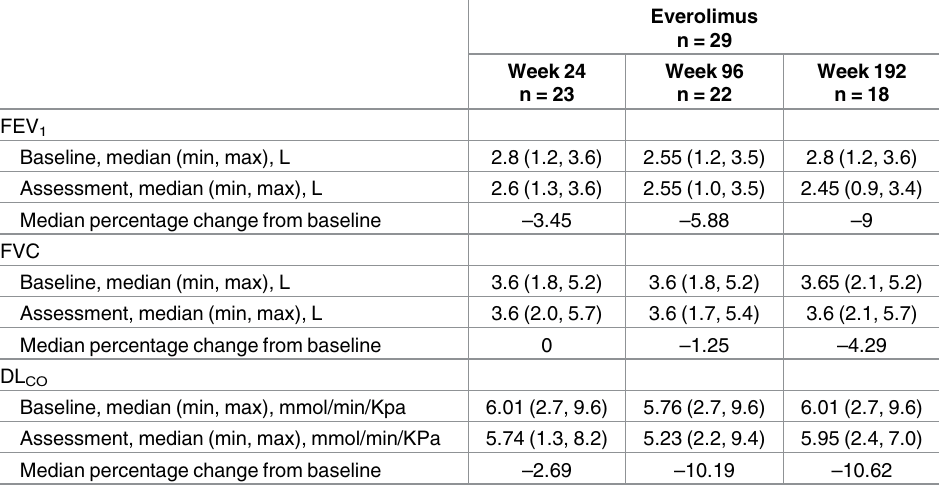
Table 2. Pulmonary function tests in patients with LAM over time.